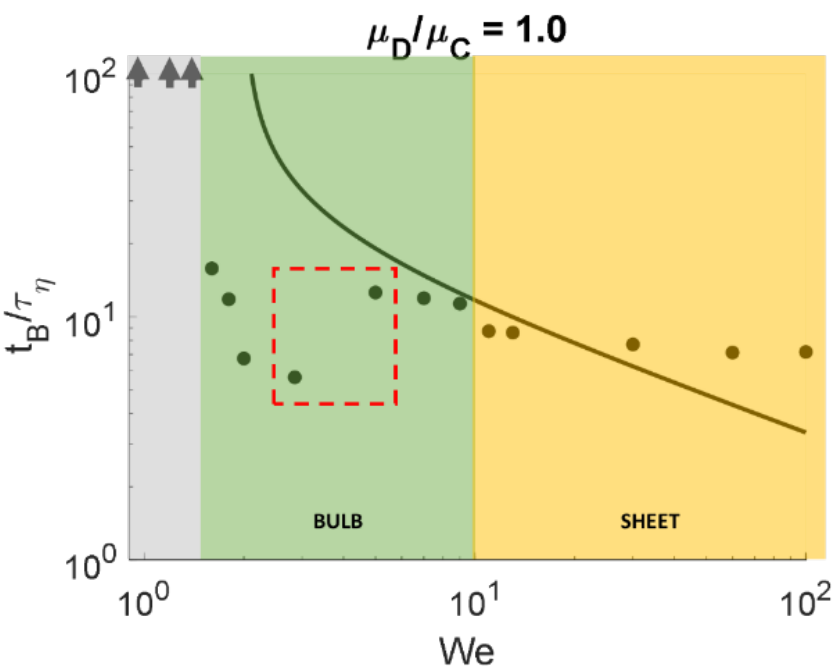
Figure 3. Time of initial breakup, t B , as a function of Weber number, We , for a low viscosity drop ( µ D / µ C = 1). Solid line displays average breakup time as suggested by Rivi è re et al. [24]. Arrows